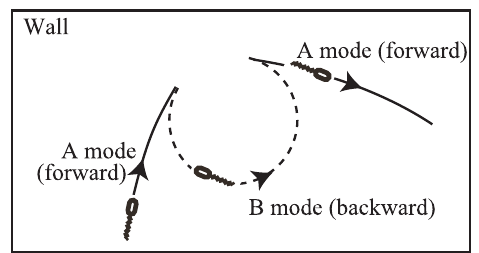
Fig. 2 Schematic illustration of a typical trajectory of a YM4 cell swimming near a rigid boundary. The rigid boundary exists parallel to this page and below the trajectory indicated by solid and broken lines. It is presumed that A mode and B mode correspond to forward and backward swimming,